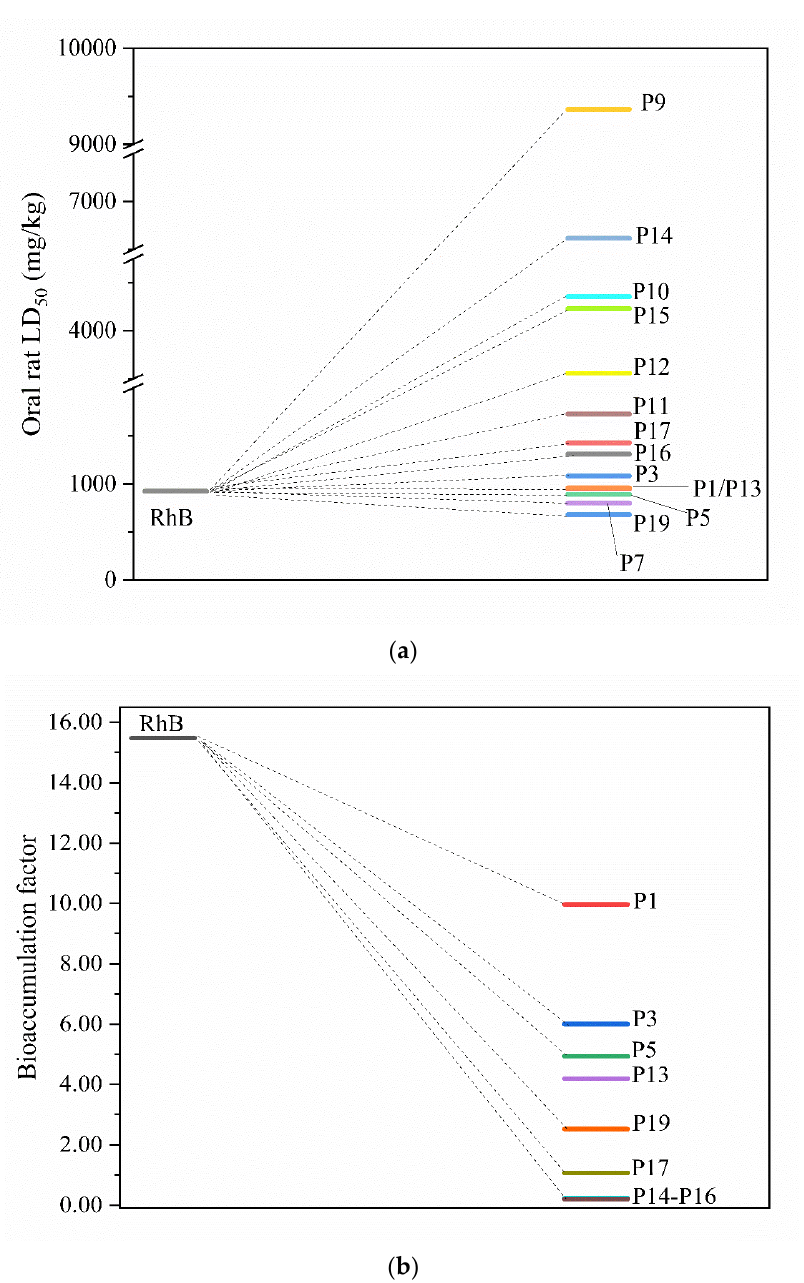
Figure 10. Oral rat LD 50 ( a ) and bioaccumulation factors ( b ) of RhB and its